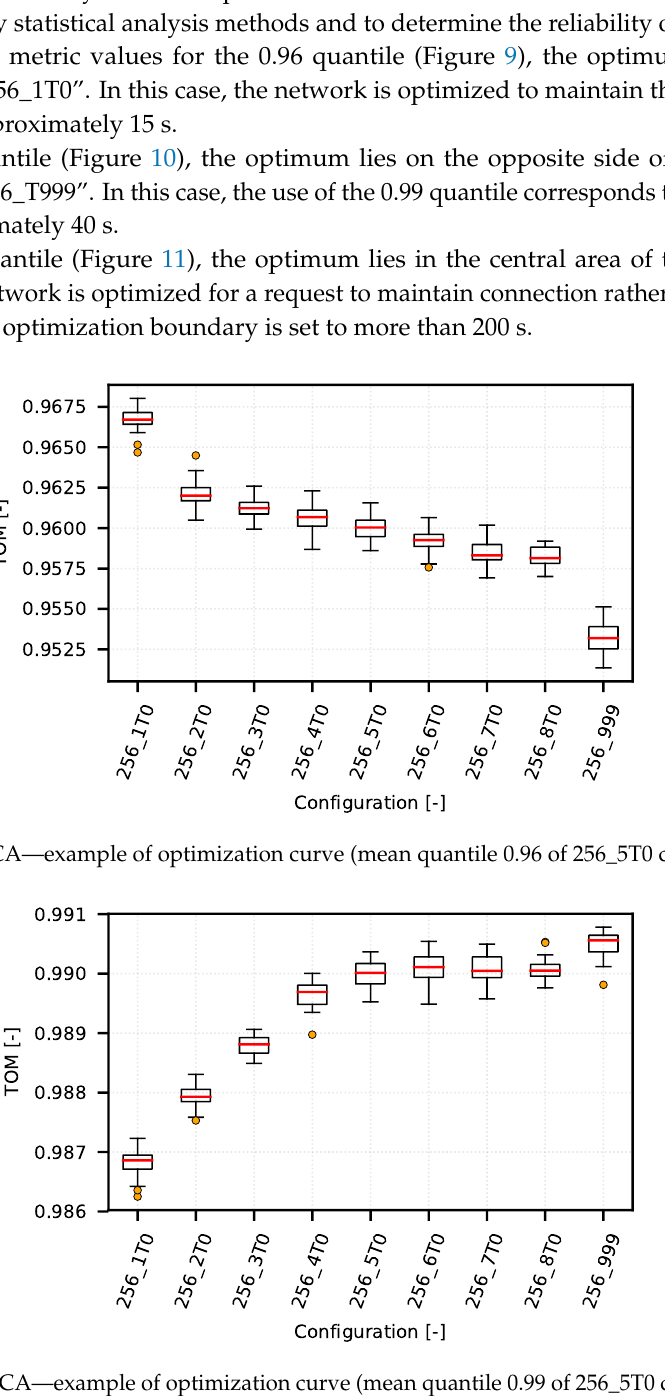
Figure 10. CSMA/CA—example of optimization curve (mean quantile 0.99 of 256_5T0